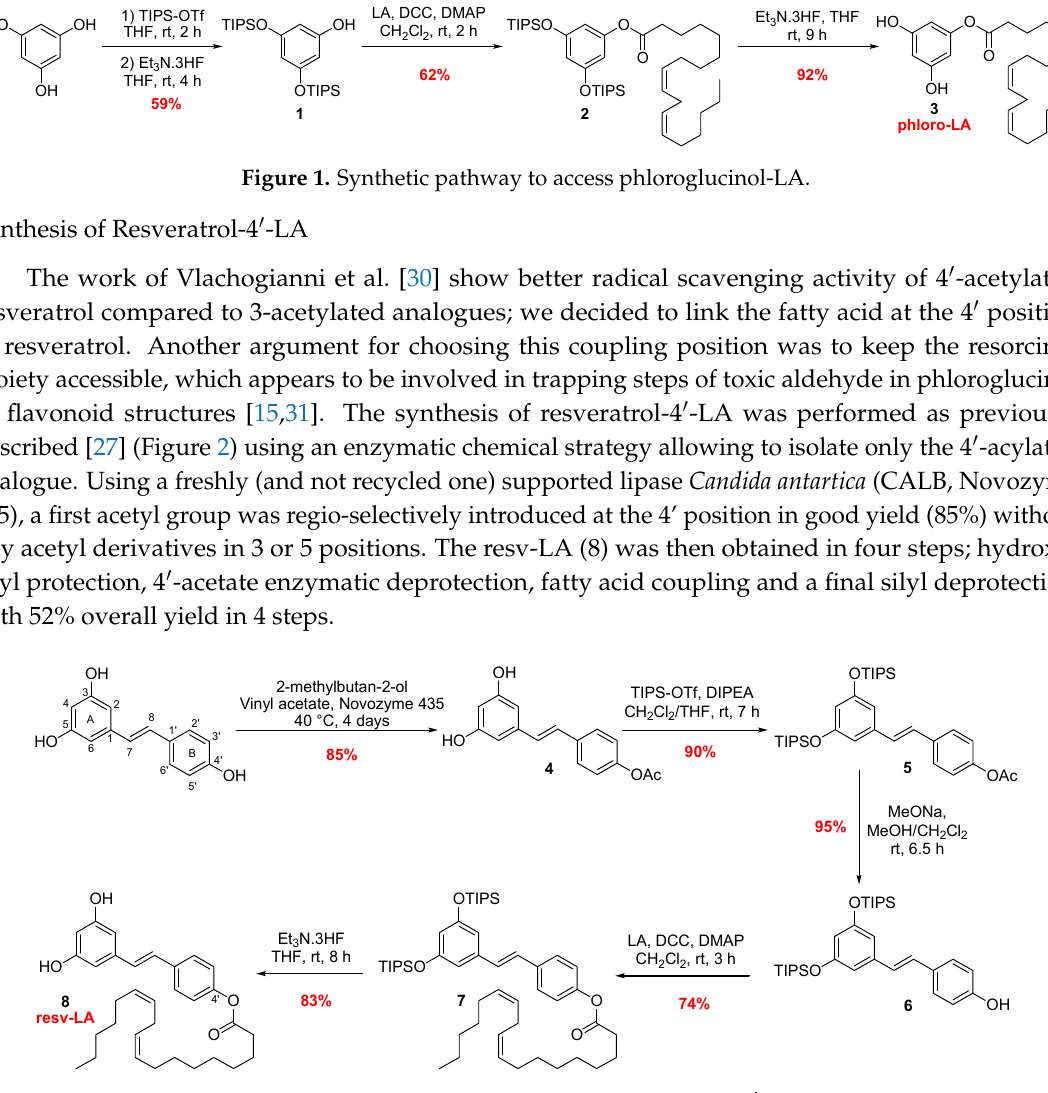
Figure 2. Synthetic pathway to access resveratrol-4 ′ -LA.